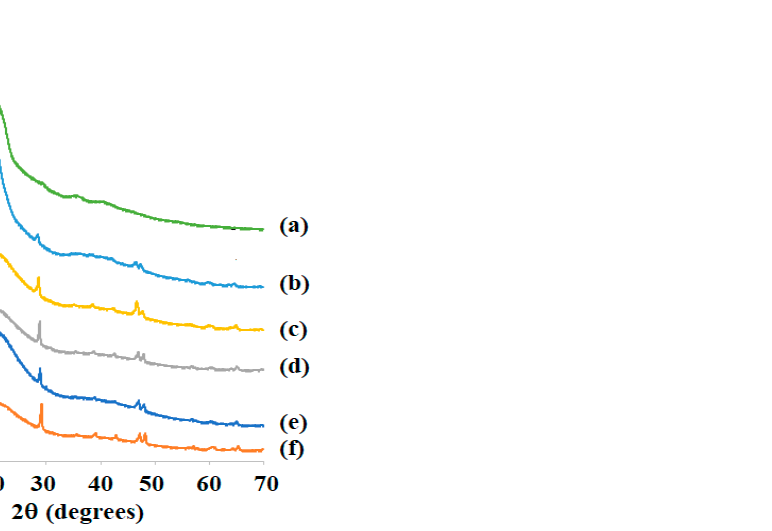
Figure 3. X-ray diffractograms of freeze-dried chitosan solutions prepared with 0 ( a ), 0.2 ( b ), 0.4 ( c ), 0.6 ( d ), 0.8 ( e ), and 1.0% ( f ) of acetic acid solutions.